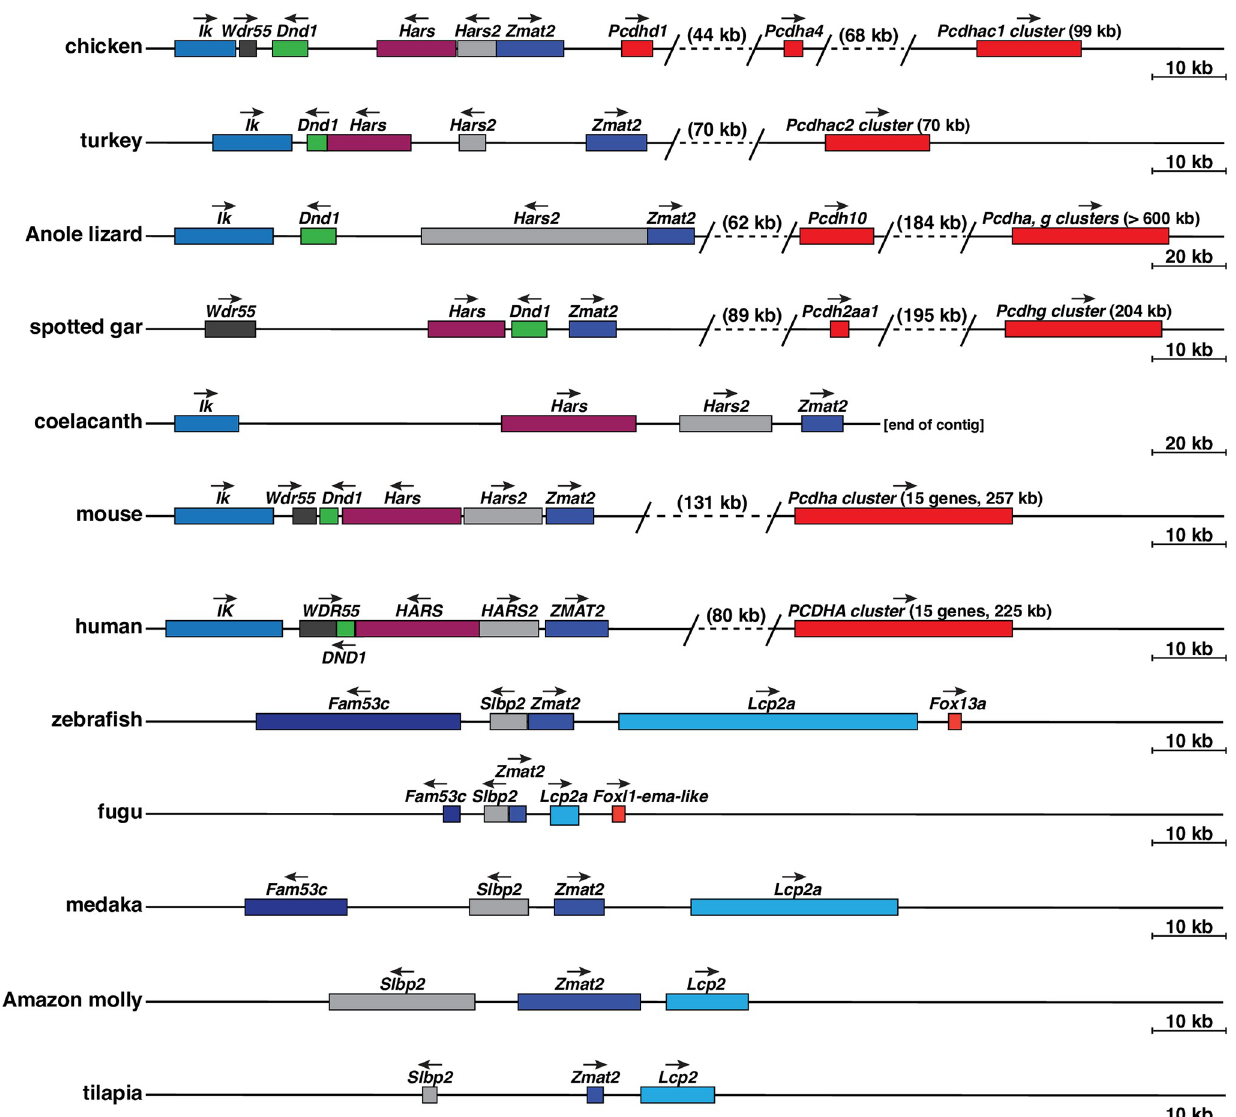
Fig 9. The Zmat2 locus in mammals and non-mammalian vertebrates. Diagrams of the ZMAT2 / Zmat2 locus in chicken, turkey, Anole lizard, spotted gar, coelacanth, mouse, human, zebrafish, fugu, medaka, Amazon molly, and tilapia. The coordinates of individual genes are depicted as single boxes and color-coded, and include the following: Ik / IK , Wdr55 / WDR55 , Dnd1 / DND1 , Hars / HARS , Hars2 / HARS2 , Zmat2 / ZMAT2 , Pcdh1 , Pcdha4 , Pcdhac1 , Pcdha / PCDHA , Pcdhg (gamma), Pcdh10 , Pcdh2aa1 (alpha a1), Fam53c , Slbp2 , Lcp2a , Lcp2 , Fox13a , Foxl1-ema-like . A horizontal arrow defines the direction of transcription for each gene. Scale bars are shown. Angled parallel lines indicate discontinuities, with the distances being spanned listed in parentheses.